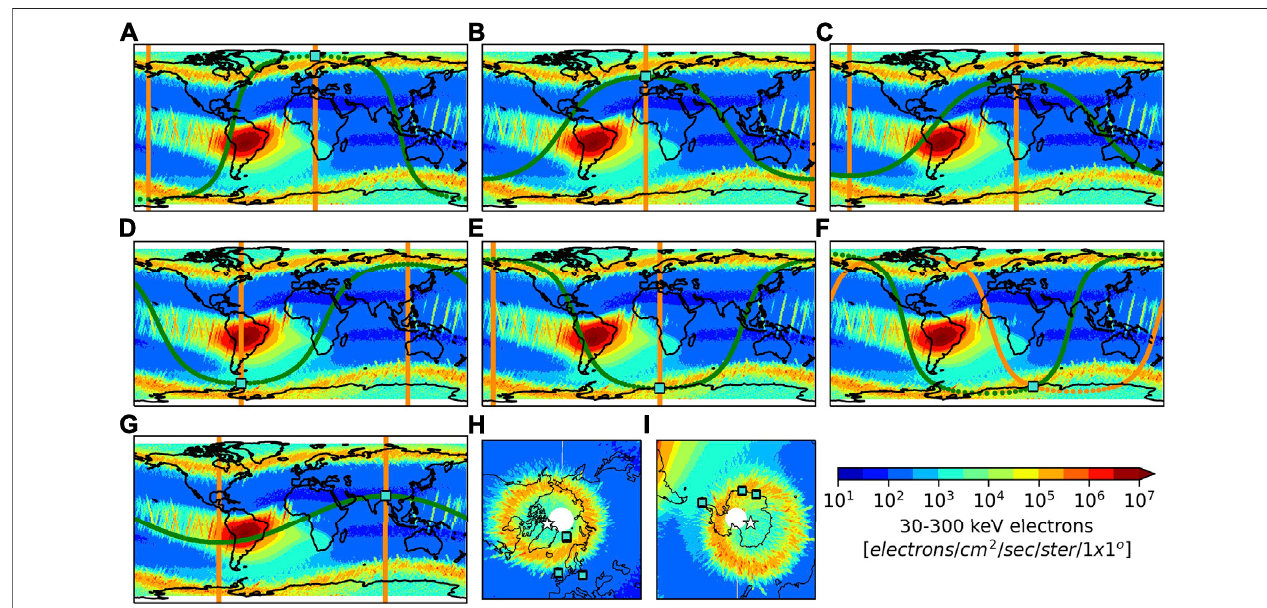
FIGURE 2 | The location of the (A) Hornsund (HRN)/Sousy (SOU), (B) Eskdalemuir (ESK), (C) Belsk (BEL), (D) Vernadsky (VRN), (E) Maitri (MAI), (F) Syowa (SYO) and (G) Shillong (SHI) SR stations (turquoise squares) and the wave propagation directions (great circle paths) for which the coils are the most sensitive (H NS (cid:1) green, H EW (cid:1) orange). Note that at the SYO station the coils are oriented along the geomagnetic north-south and east-west directions. The background world maps show the distributionofprecipitated30 – 300 keVelectronsin1 × 1degreespatialresolutionin2005(yieldingthehighestprecipitation fl uxesinthetimeintervalinvestigatedin this study) provided by the NOAA-15 satellite. The polar views (|lat| > 40 ° ) of the Northern (H) and Southern (I) Hemispheres together with the location of the high- and mid-high latitude SR stations and the geomagnetic poles (white stars).